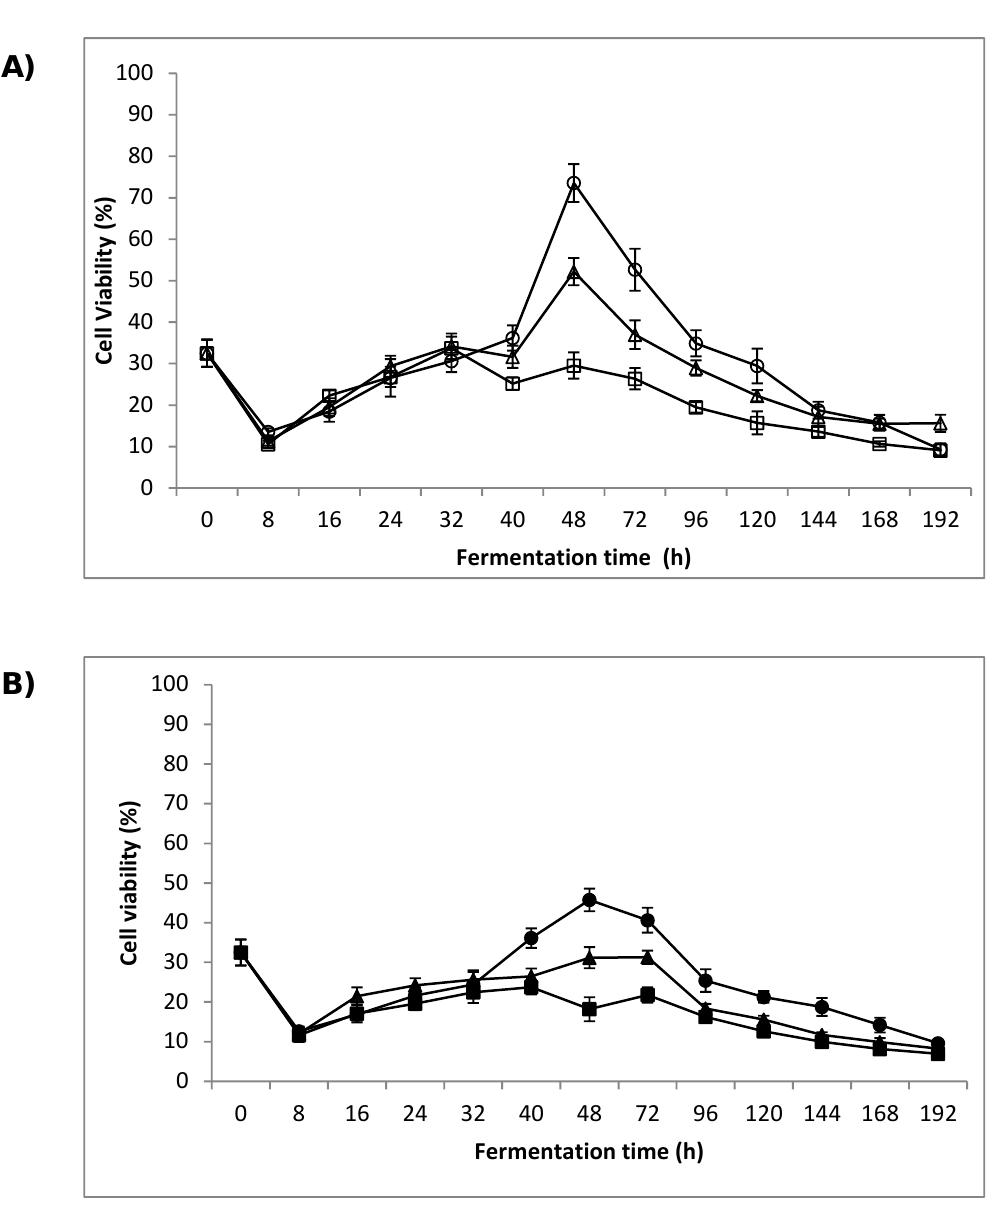
Figure 8. ( A ) Yeast cell viability (%) of non-NaCl-stressed cells during various fermentation times (h) with three different media containing 200, 300, or 400 g/L glucose after cell treatment with sonication ( n = 3 replications for each time and error bars represent standard deviation of the average value of all replications with each range of fermentation time); ( B ) Yeast cell viability (%) of NaCl-stressed cells during various fermentation times (h) with three different media containing 200, 300, or 400 g/L glucose after cell treatment with sonication ( n = 3 replications for each time and error bars represent standard deviation of the average value of all replications with each range of fermentation time) ( ): (200 g/L glucose, 0% NaCl), ( ∆ ): (300 g/L glucose, 0% NaCl), ( (cid:3) ): (400 g/L glucose, 0% NaCl), (cid:35) ( ): (200 g/L glucose, 6% NaCl), ( ∆ ): (300 g/L glucose, 6% NaCl), ( (cid:4) ): (400 g/L glucose, 6%